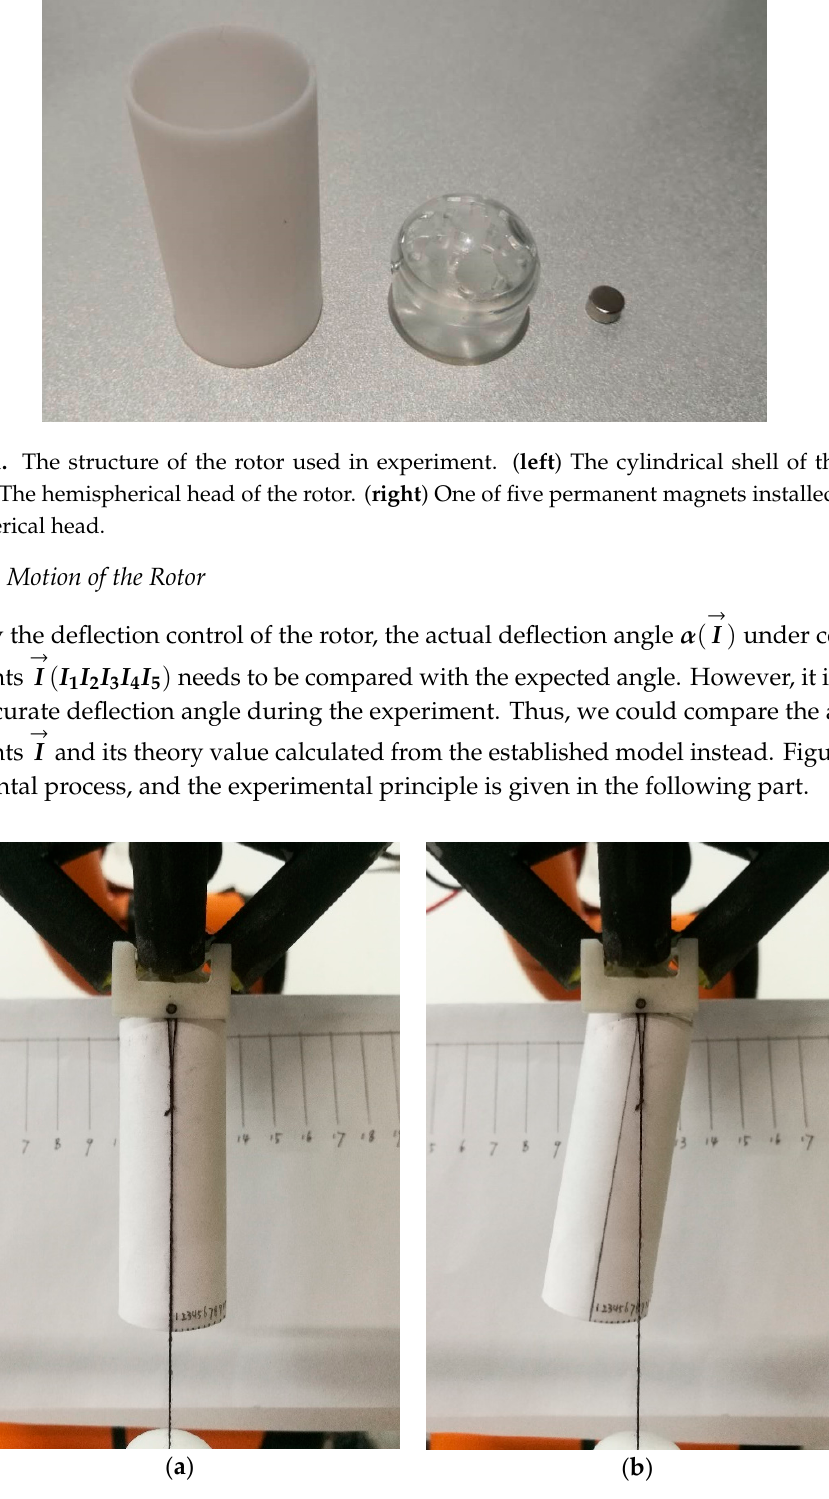
Figure 10. The translational and rotational motion of the rotor. ( a – c ) exhibit the translational motion of the rotor in different position. ( d – f ) show the rotational motion of the rotor in different angle, where a black line on the rotor surface indicate the rotational motion of the rotor.